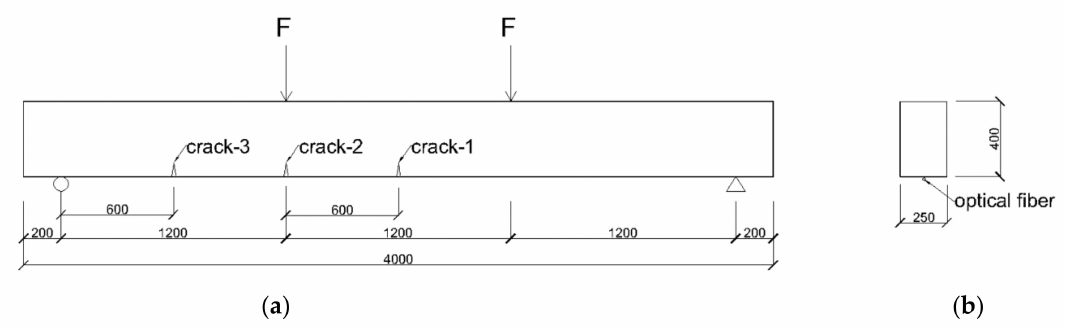
Figure 7. Setup of numerical example ( a ) side view of RC beam ( b ) cross section of RC